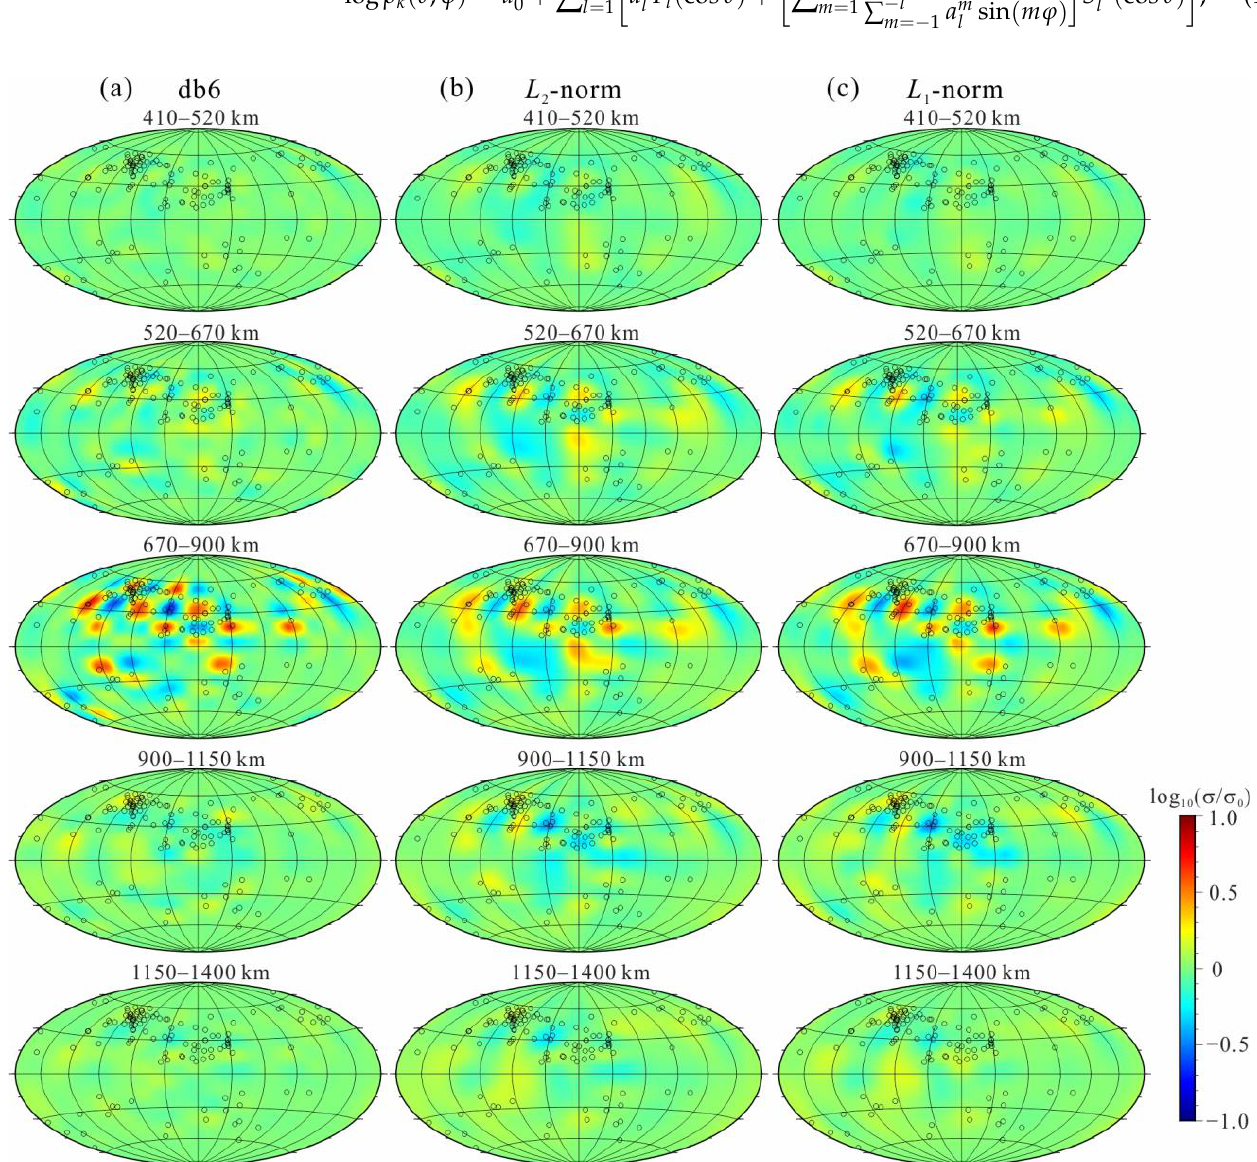
Figure 9. Inversion results of the checkerboard model from synthetic responses. Wavelet-based inversion (a: db6) and L p -norm (b: L 2 -norm, c: L 1 -norm) inversions are drawn.